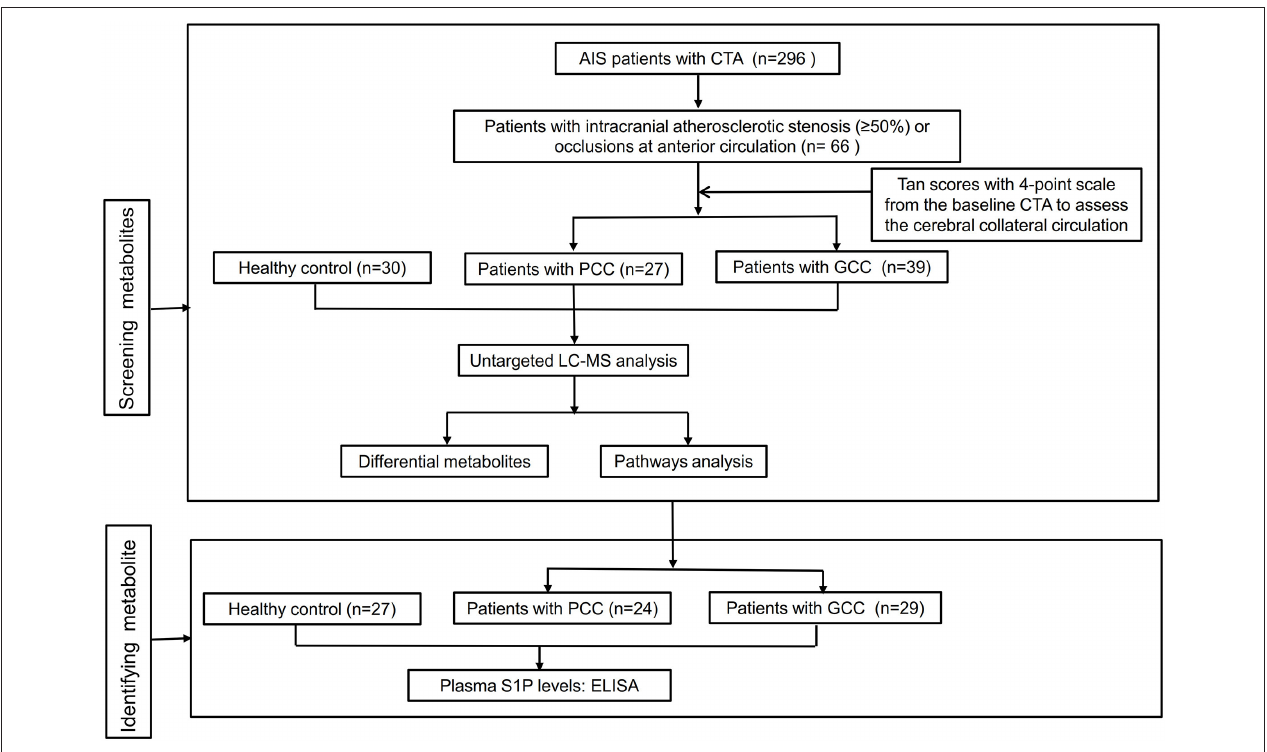
FIGURE 1 | Flowchart of the study design. AIS, acute ischemic stroke; CTA, computed tomographic angiography; GCC, good collateral circulation; PCC, poor collateral circulation; LC-MS, liquid chromatography-tandem mass spectrometry; S1P, sphingosine-1-phosphate; ELISA, enzyme-linked immunosorbent assay.